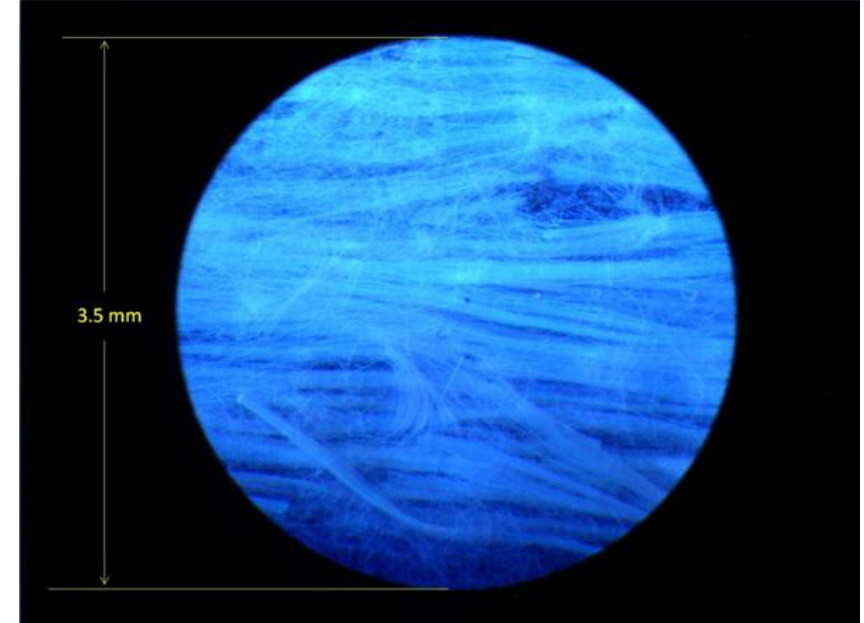
Figure 7. Anthracene fibers extracted from the quartz cladding and arranged as a thin film for XRD surface analysis at 50× magnification under UV light. The 2.5 micron diameter fibers form a yarn of anthracene